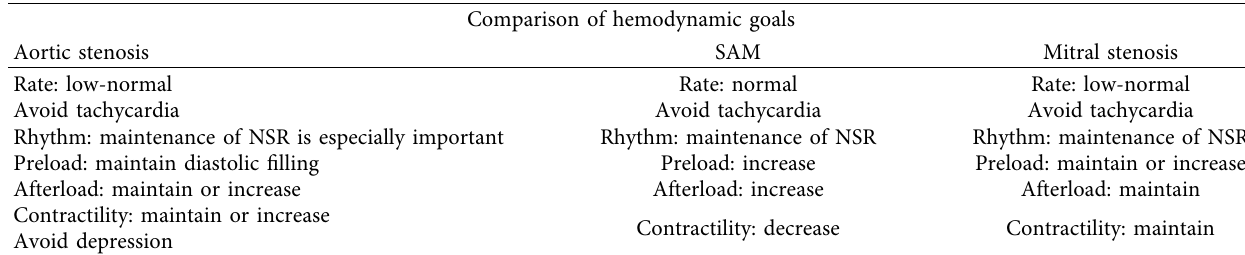
Table 2: Comparison of hemodynamic goals of aortic stenosis, mitral stenosis, and systolic anterior motion of the mitral valve causing left ventricular outfow tract obstruction [13, 14]. Comparison of hemodynamic goals Aortic stenosis SAM Mitral